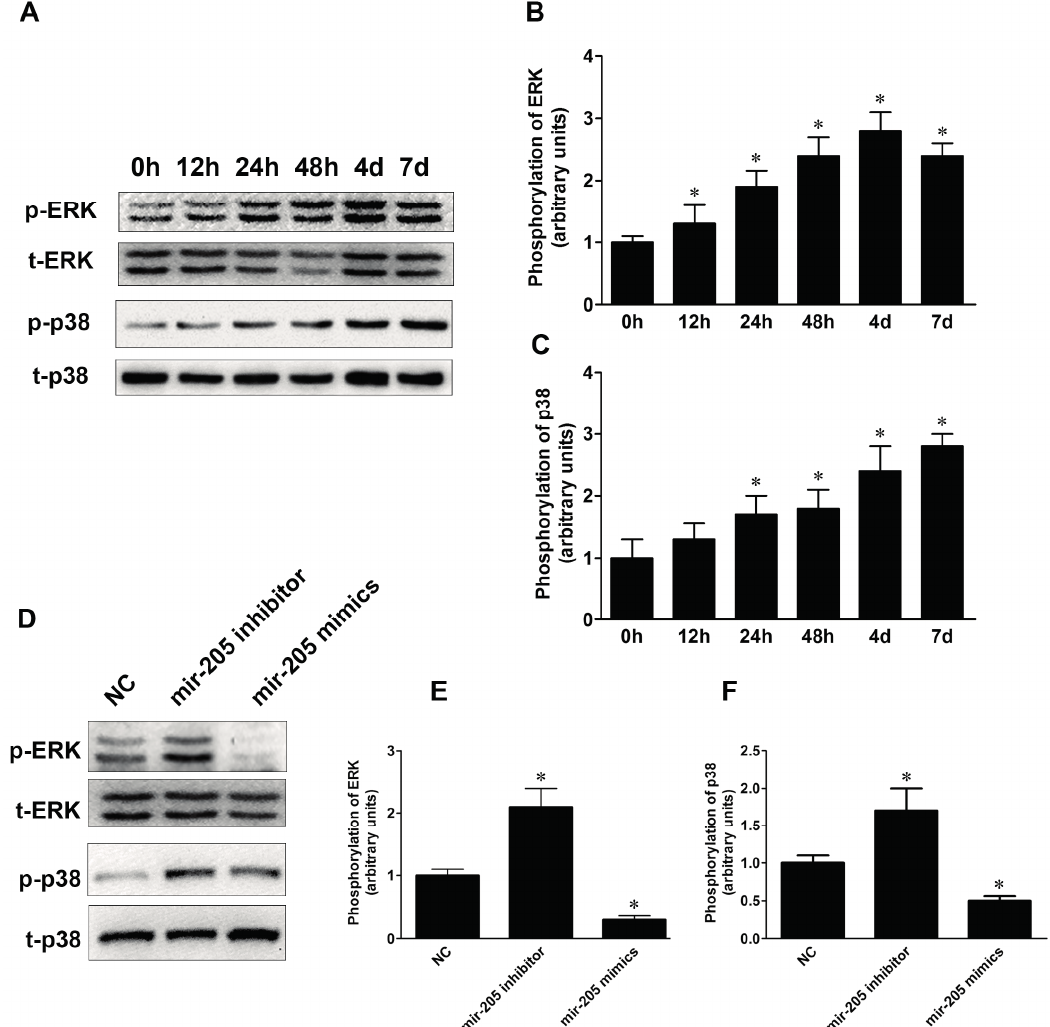
Figure 5. Phosphorylation of extracellular signal-regulated kinase (ERK) and p38 mitogen-activated protein kinase (MAPK) during the osteogenic differentiation of BMSCs. ( A – C ) Phosphorylation of ERK and p38 MAPK during the osteogenic differentiation. * p < 0.05 vs. 0 h; ( D – F ) BMSCs were treatment with DM and western blot analysis